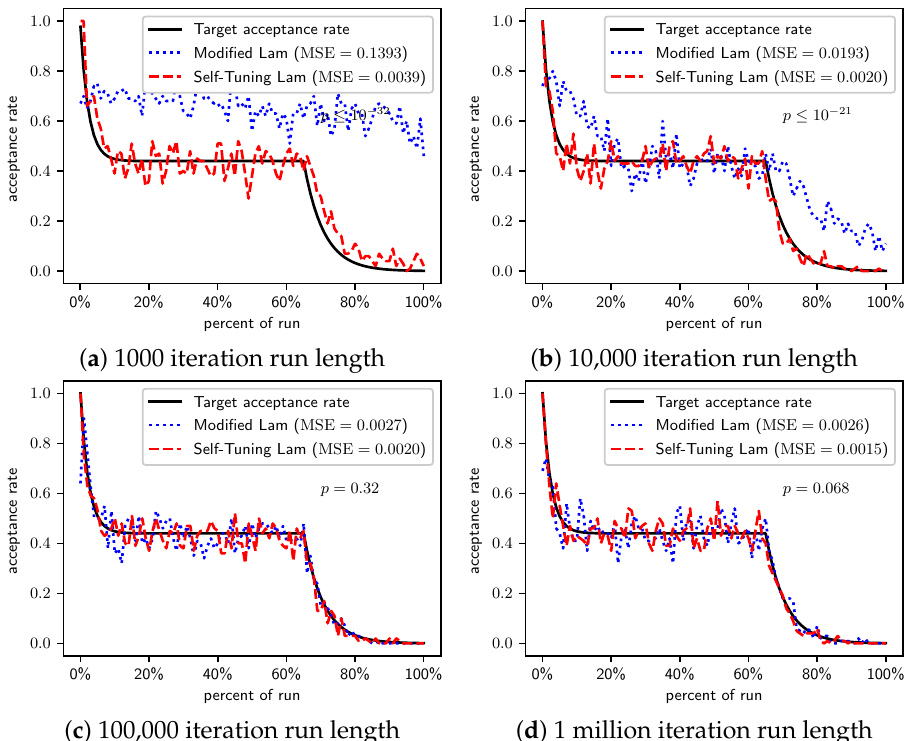
Figure 12. Minimize f 2,1 ( x ) : Self-Tuning Lam, Modified Lam, and target acceptance rates for ( a ) 1000 iterations, ( b ) 10,000 iterations, ( c ) 100,000 iterations, and ( d ) 1 million